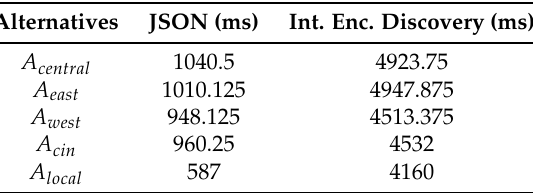
Table 4. Average run-times in milliseconds